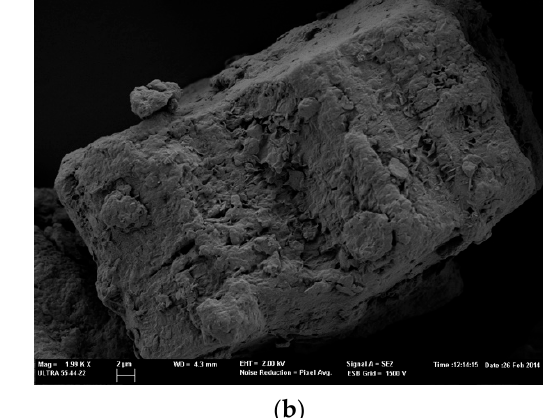
Figure 2. FESEM images of MMT K10 microparticles. ( a ) At 500× magnification and ( b ) at 2000× magnification.